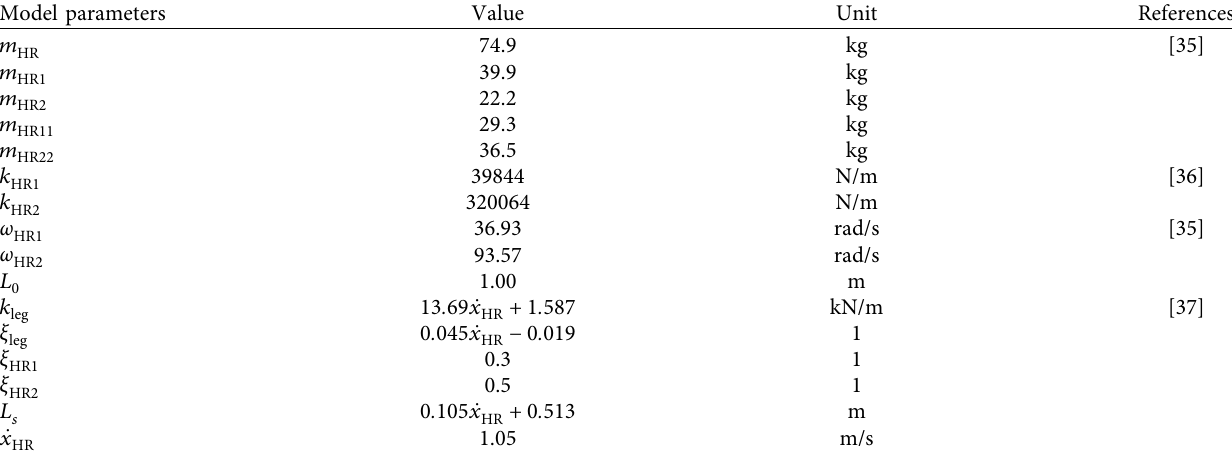
Table 1: Parameters of the bipedal walking